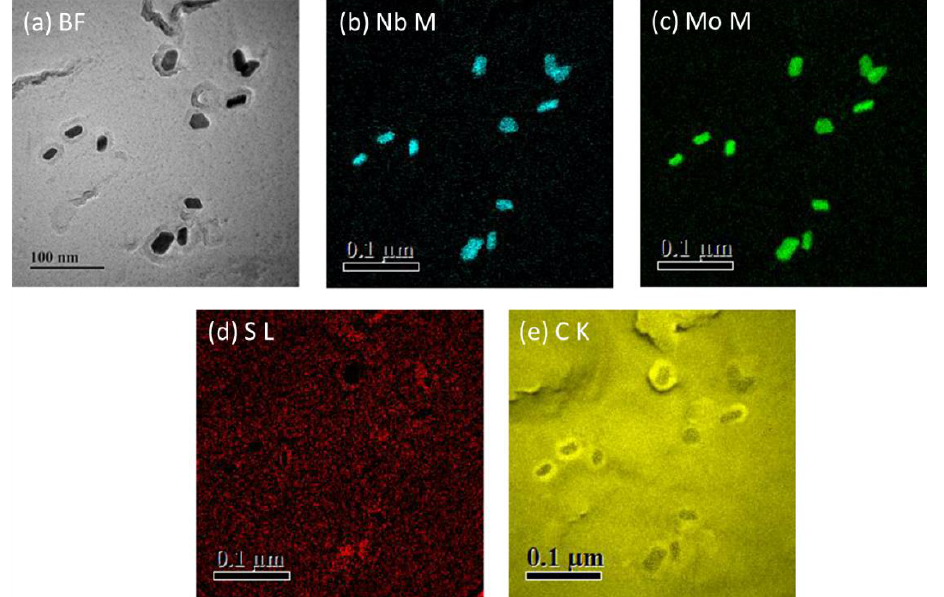
Figure 7. Electron energy loss spectroscopy (EELS) examination of the carbon replicas for the chemistry of the precipitates in the Nb-Mo steel after isothermal holding at 900 °C for 3000 s: ( a ) BF TEM image; ( b ) Nb; ( c ) Mo; ( d ) S; ( e ) C.